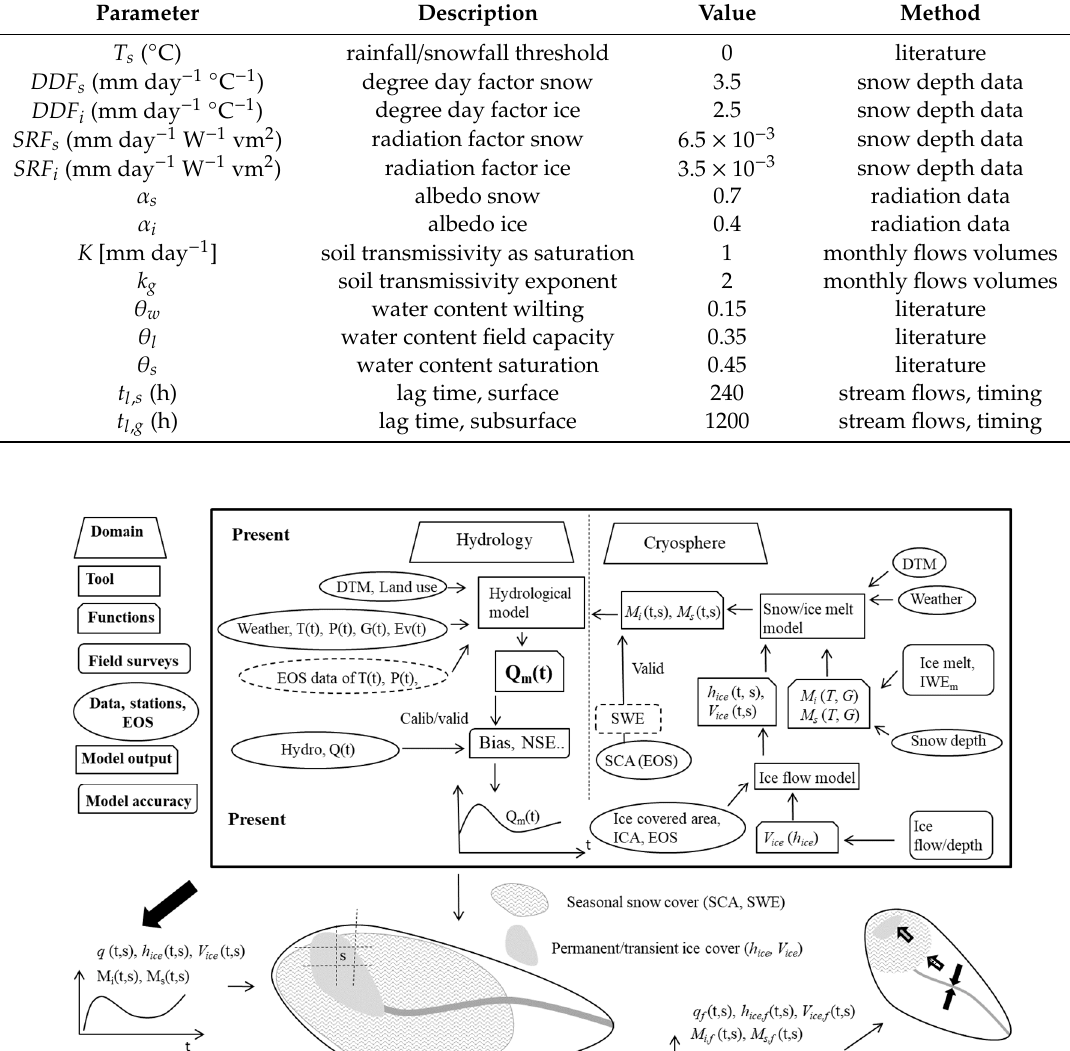
Table 2. Poli-Hydro model parameters, and corresponding values. In bold , calibration parameters.